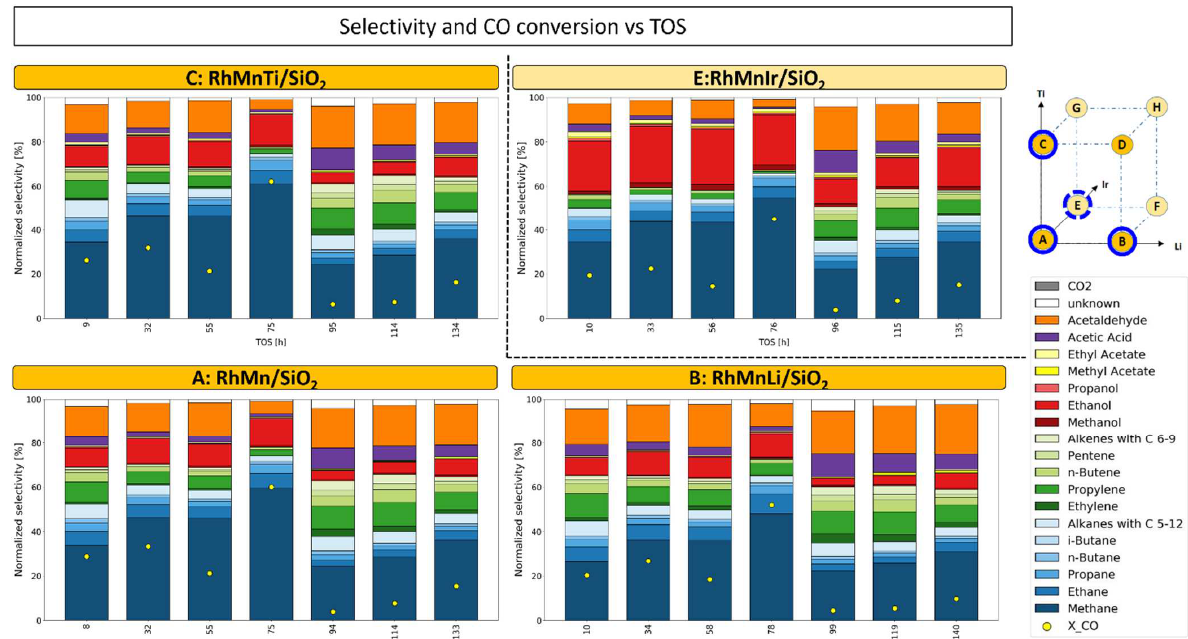
Figure 3. Distribution of products’ selectivity in Exp 1 (T = 270 °C, P = 50 bar, total flow = 43 mL/min, H 2 :CO = 48:22 %V). For the base RhMn catalyst and three promoted RhMn catalysts (shown on the right), the selectivity is plotted in seven different experimental conditions. Individual experimental conditions are separated by black dashed lines. In each experiment, four measurements were taken.